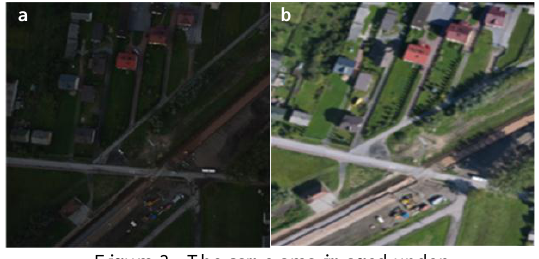
Figure 3. The same area imaged under a) cloudy sky and fog b) under a clear sky and good sunlight